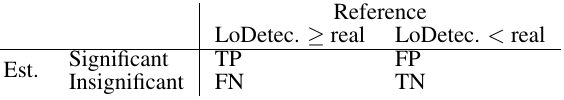
Table 2. Comparison between significance from estimation and tachymeter control measurements in form of a confusion matrix.